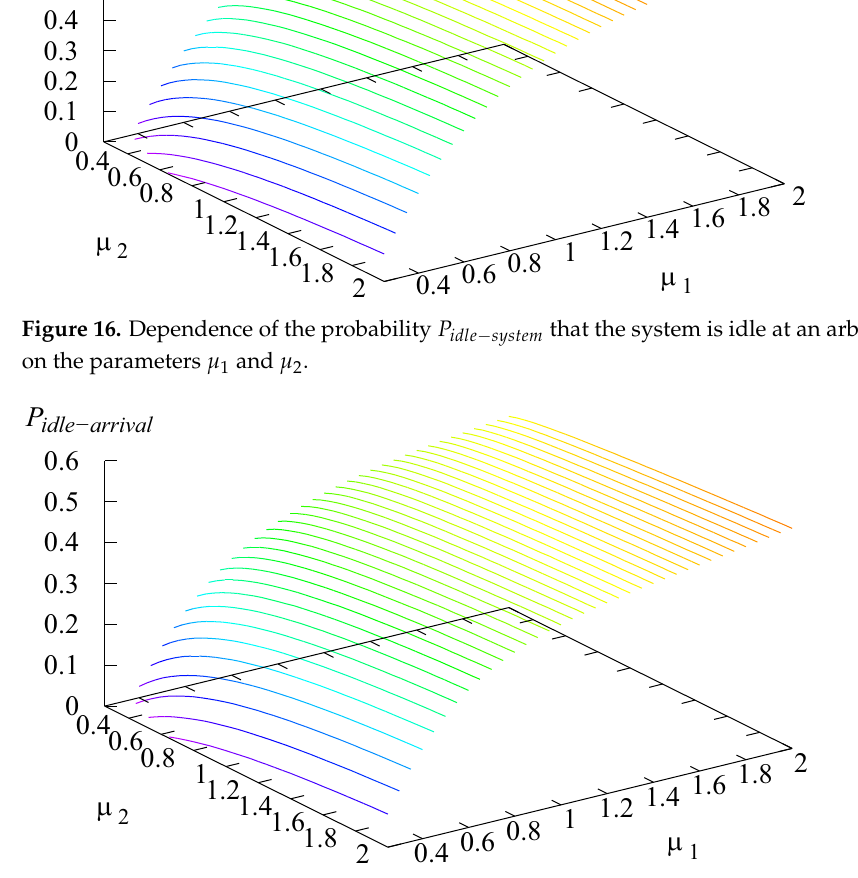
Figure 17. Dependence of the probability P idle − arrival that the system is idle at an arbitrary arrival moment on the parameters q and ν